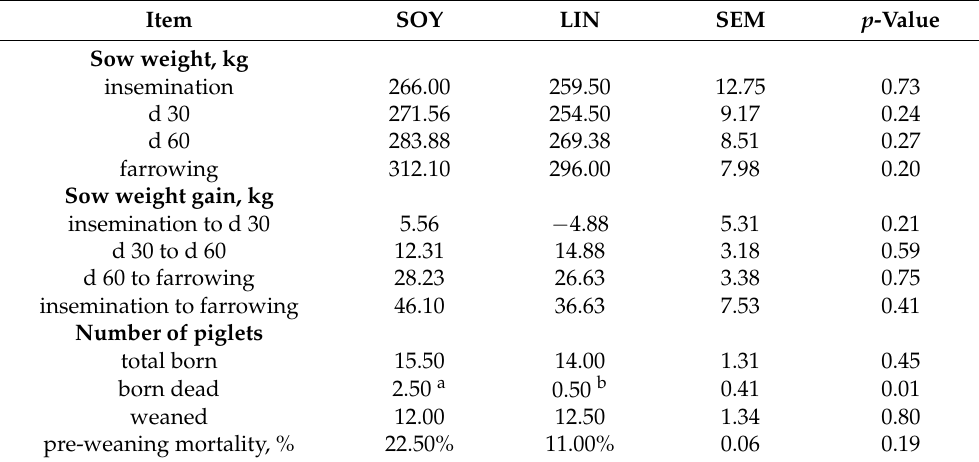
Table 1. Reproductive performance of sows between dietary treatments *. Item